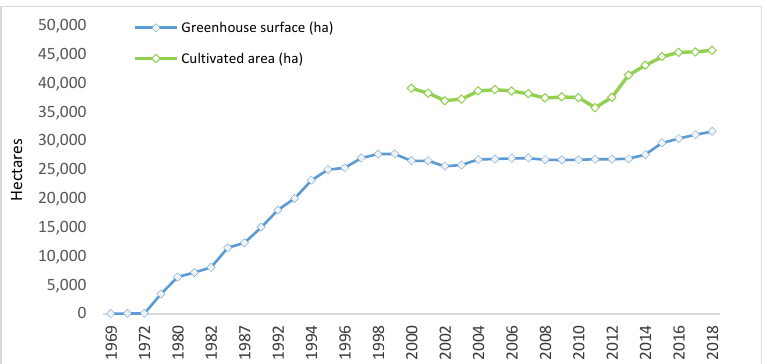
Figure 2. Evolution of physical land area and greenhouse crop area. Authors’ own elaboration based on data supplied by the Ministry of Livestock, Fisheries and Sustainable Development of the Regional Government of